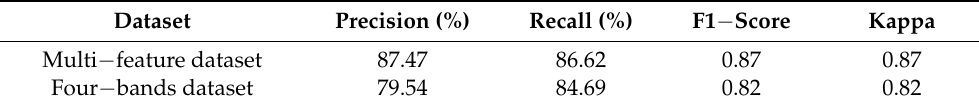
Table 5. Red tide detection accuracy of RDU − Net using different datasets.